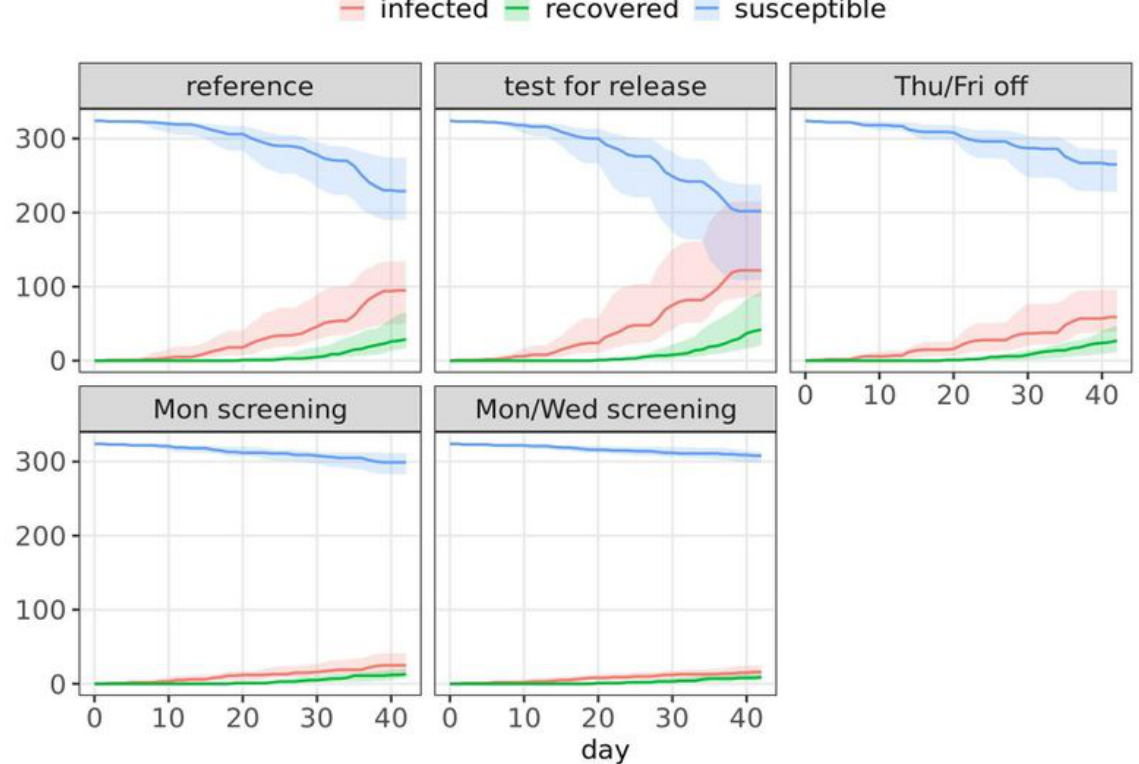
Figure 3. Median (10% and 90% quantiles) number of infected, recovered, and